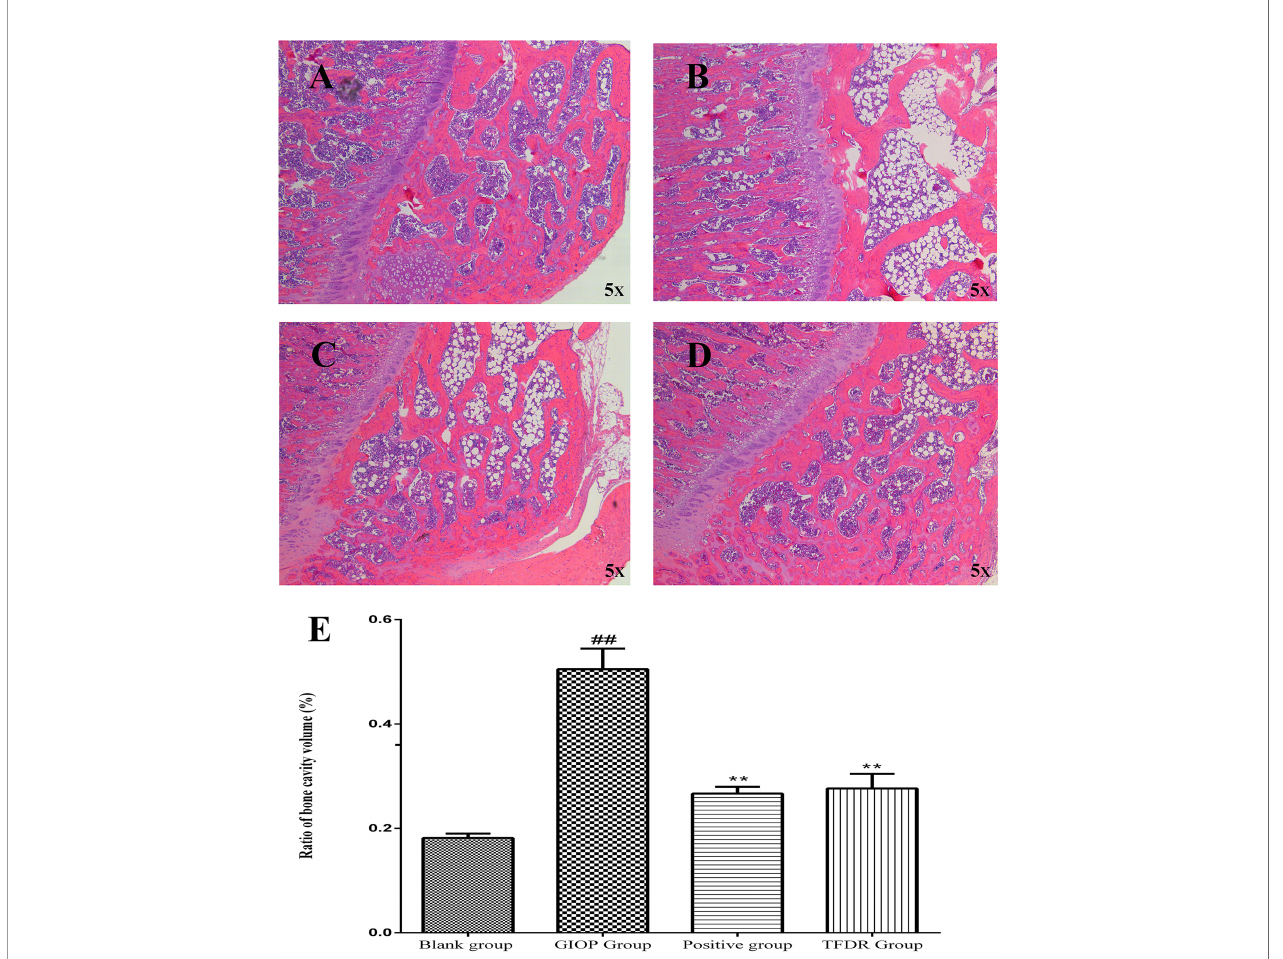
FIGURE 11 | Representative H&E staining of femoral sections from Blank (A) , GIOP (B) , Positive (C) and TFDR (D) group. (E) Ratio of bone cavity volume regarding representative H&E staining of femoral sections from different groups. Data are expressed as mean ± SEM. ## p < 0.01 vs. blank group rats; **p < 0.01 vs. GIOP group rats (n = 4).